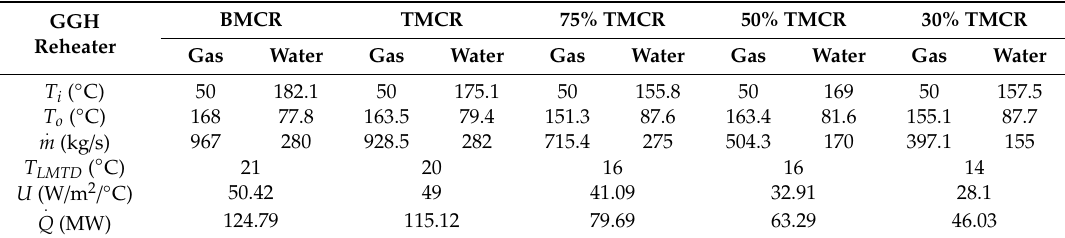
Table 5. New operating conditions for the GGH cooler in the new process based on the load conditions. Table 6. New operating conditions for the GGH reheater for the new process based on the load